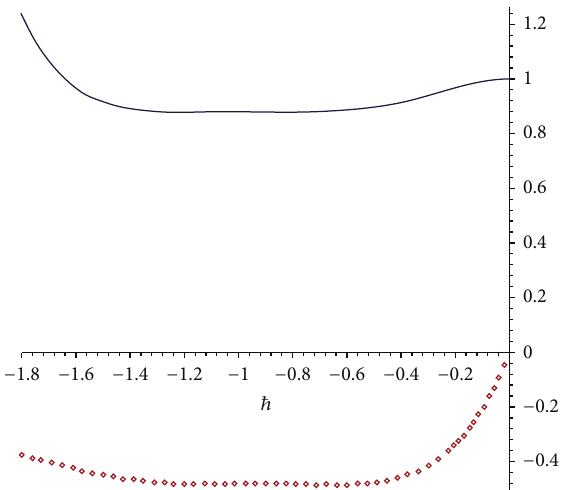
Figure 2: The ℎ -curves for the 7th-order of HAM approximation of 𝑢(0,0, 0.5, ℎ) for Example 2; dotted line: real part of approximation; solid line: imaginary part of